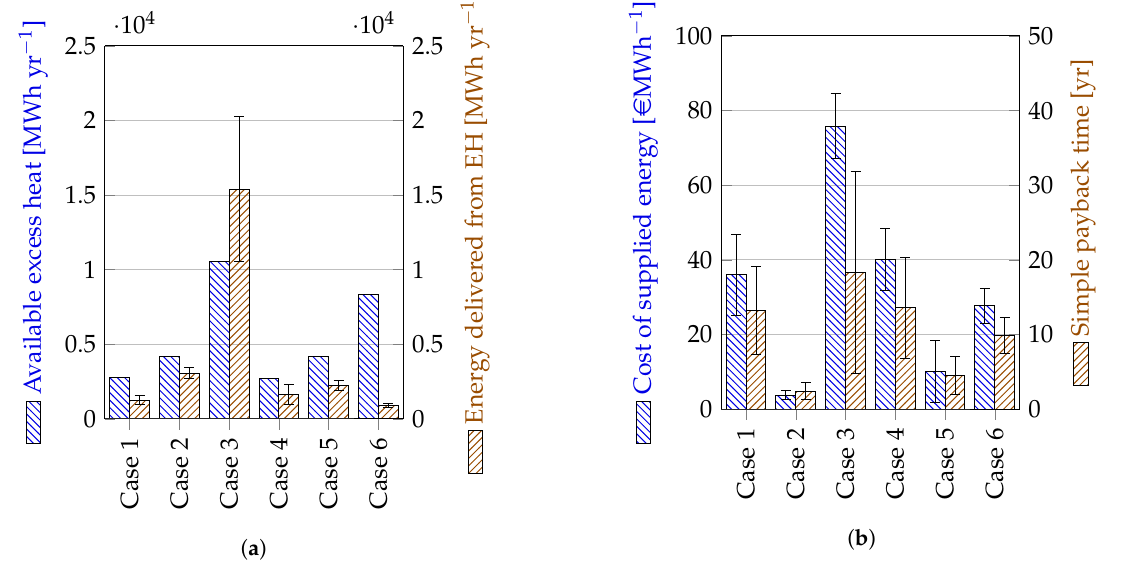
Figure 5. Main results with the standard deviation as the uncertainty range. ( a ) Energy indicators; ( b ) economic indicators.